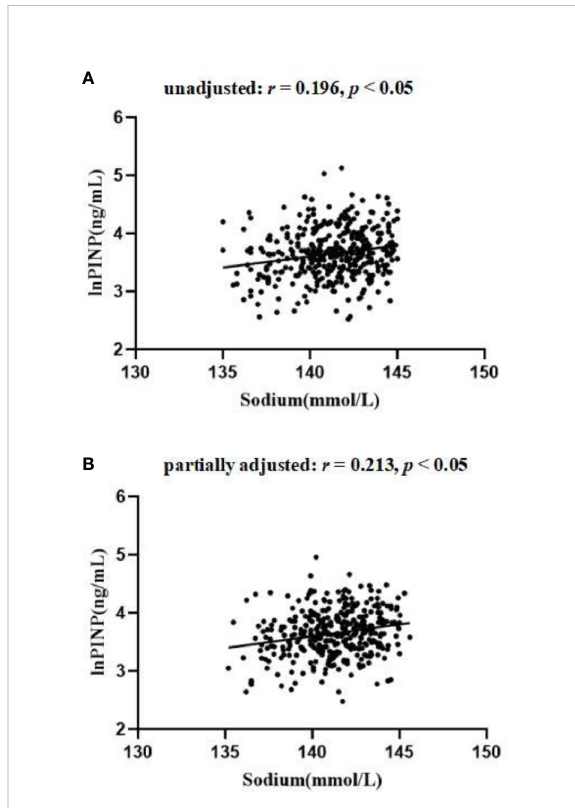
FIGURE 4 The relationship between serum sodium and lnPINP in patients with T2D (A) unadjusted; (B) partially adjusted for age, sex, BMI and